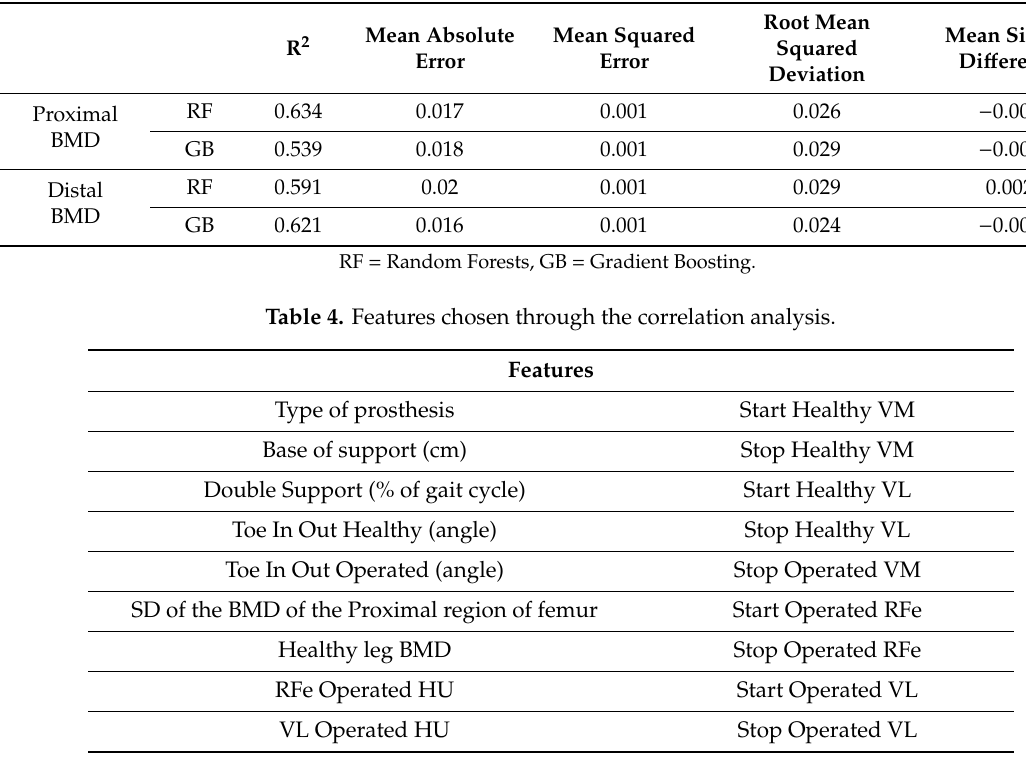
Table 3. Scores for the regression task.